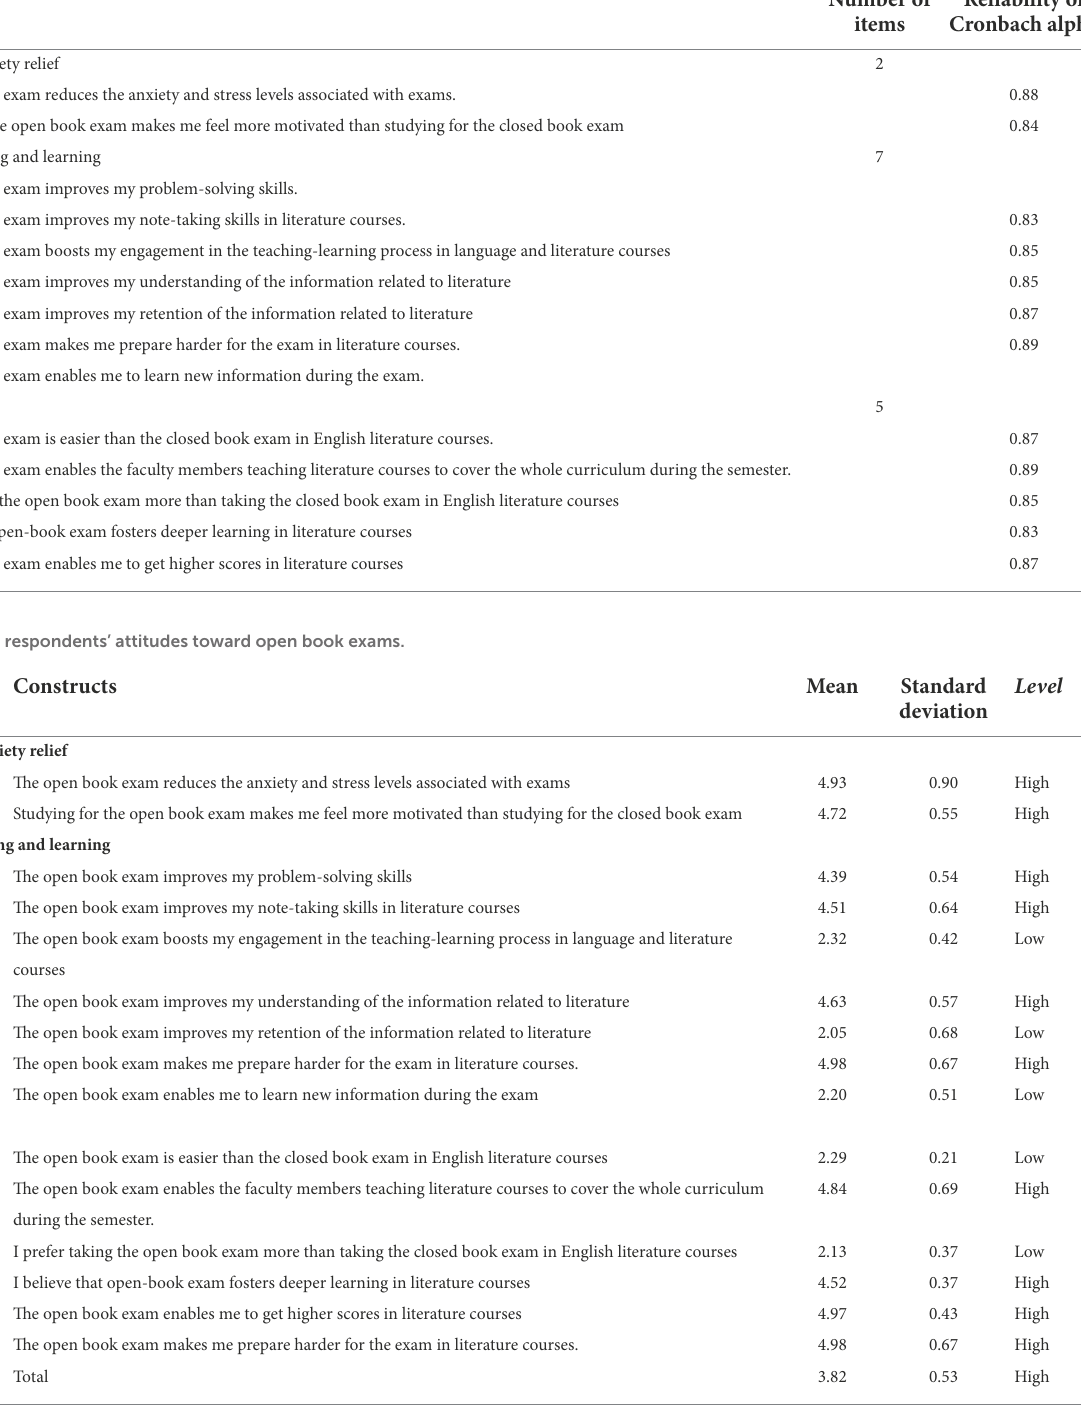
Reliability of items Cronbach alpha